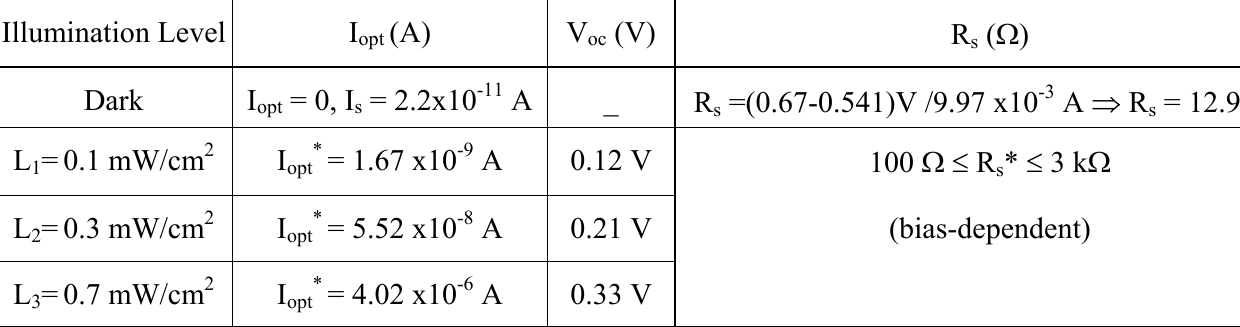
Table 1. Determination of I Illumination Level